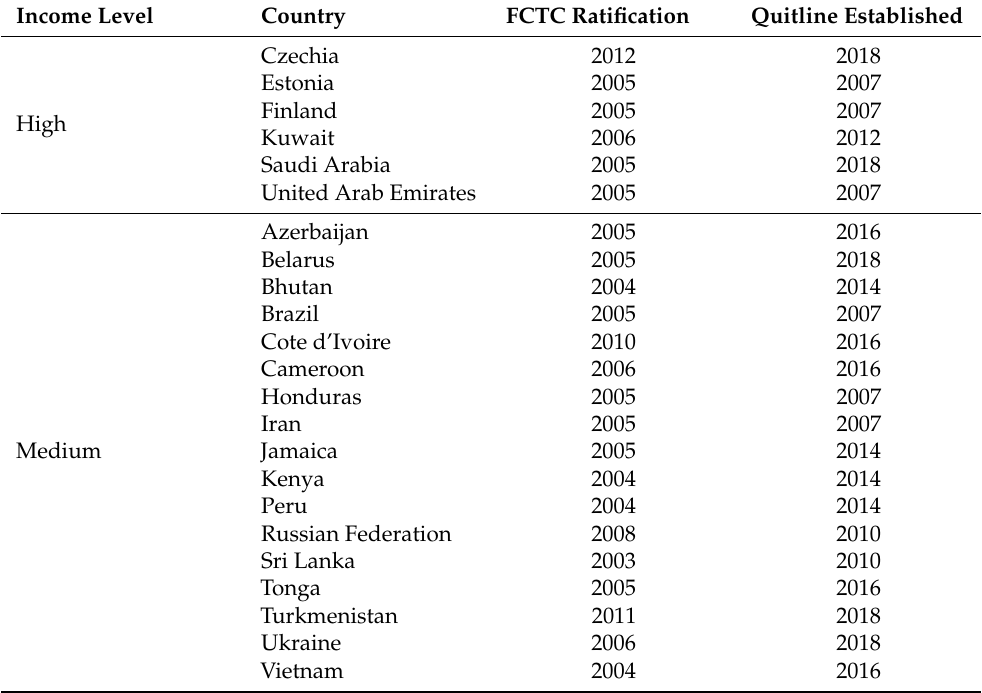
Table 2. Countries with quitlines that do not include quitline information on cigarette packaging, by income level, year of FCTC ratification, and year the quitline was